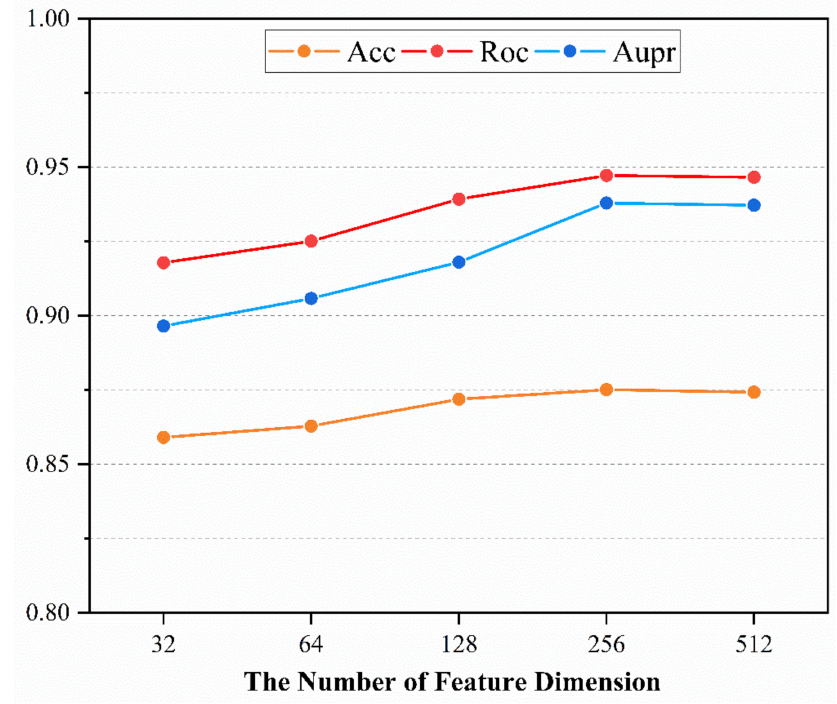
Figure 1. The main performance under different dimensions.